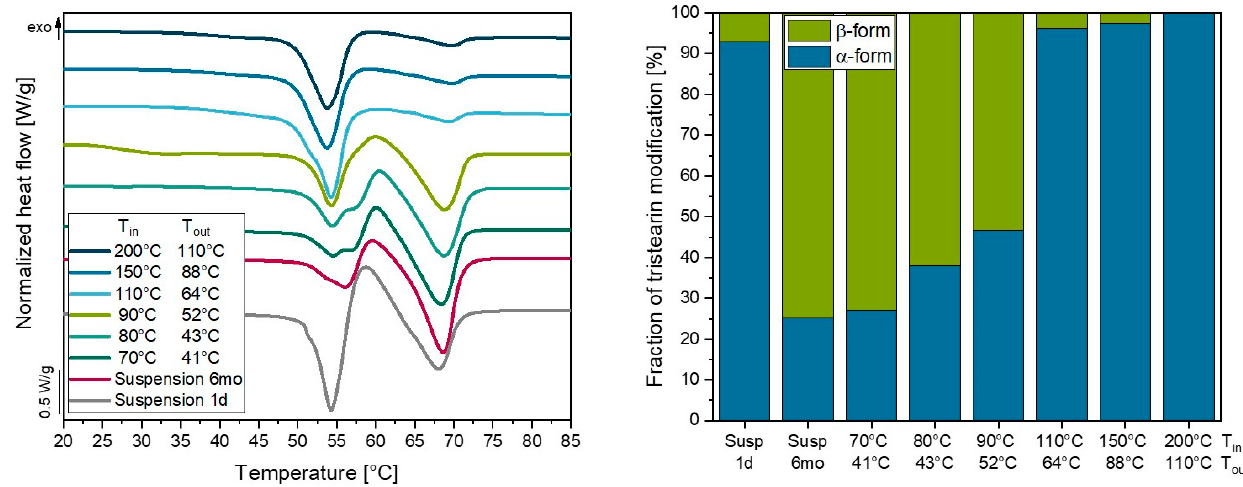
Figure 9. DSC heating curves of tristearin suspensions stabilized with HPMC/SDS during high- pressure homogenization measured one day (1 d) as well as 6 months (6 mo) after preparation and of tristearin-nanoparticle containing powders dried at different T in ( left ); fraction of tristearin in the α - and β -form in the suspensions and the powders as calculated from the DSC curves ( right ). Drying the suspension at the lowest temperature, T in = 70 °C, resulting in T out = 41 °C,